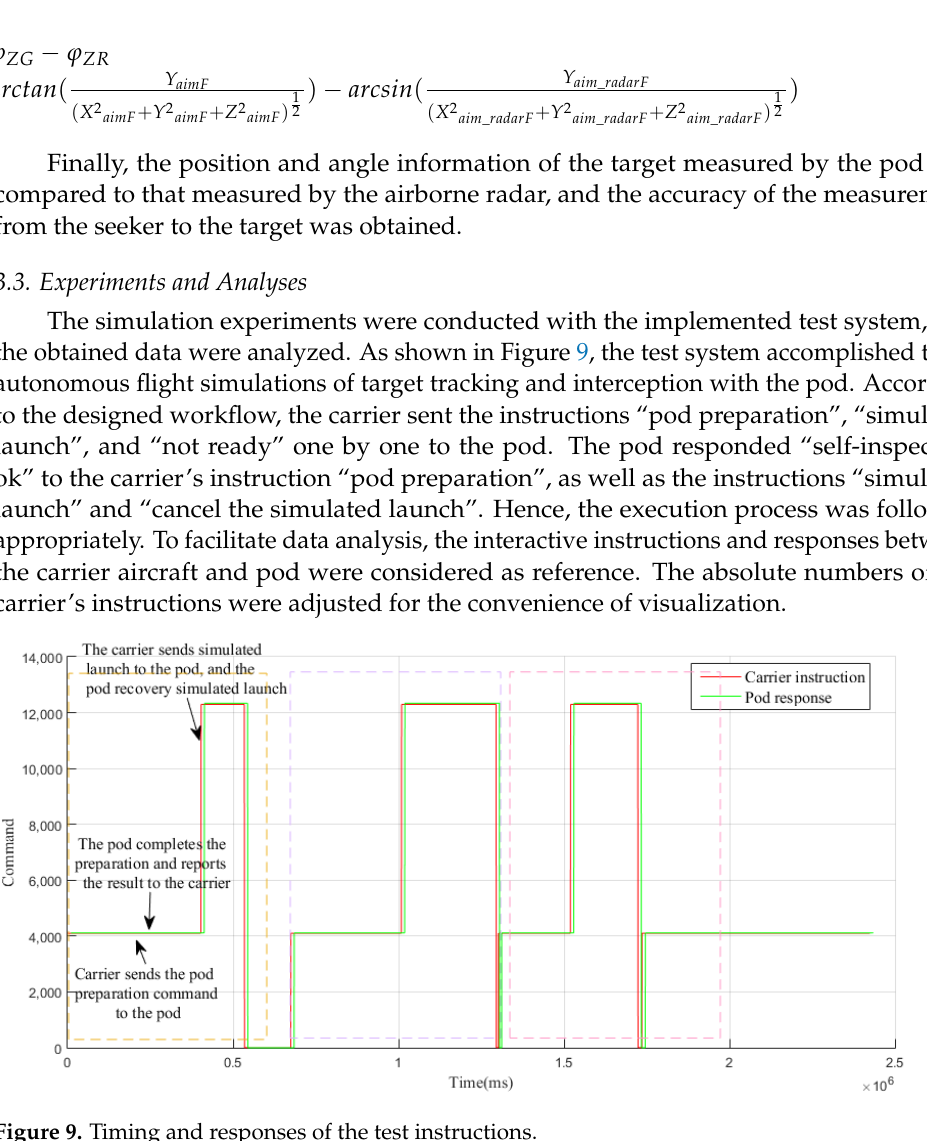
Figure 9. Timing and responses of the test instructions.